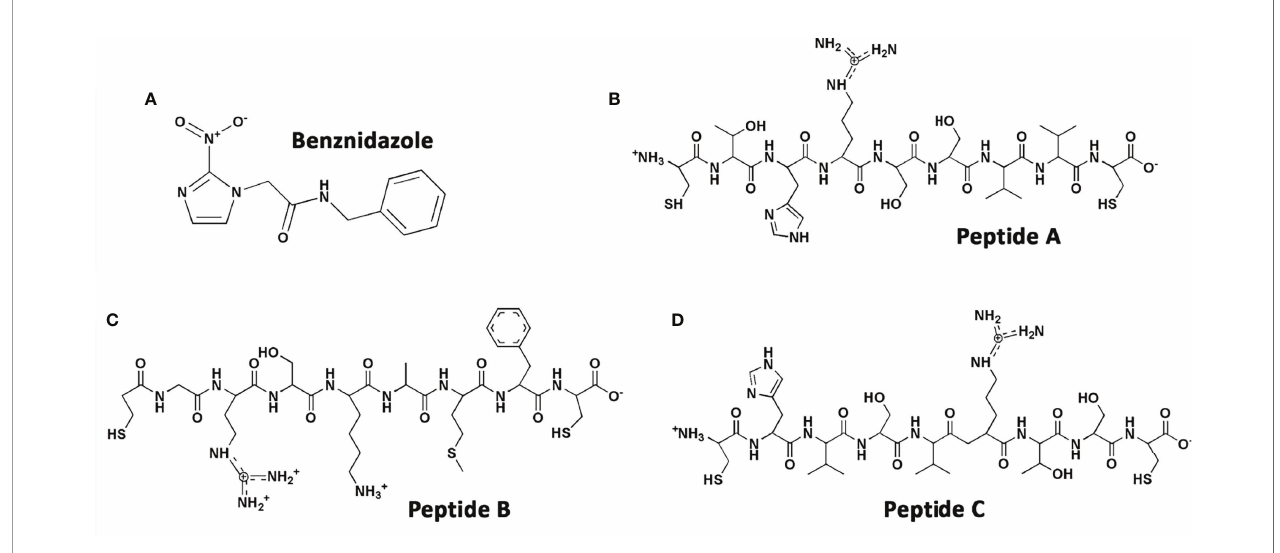
FIGURE 1 | Chemical structures of (A) benznidazole, (B) PepA, (C) PepB, and (D)